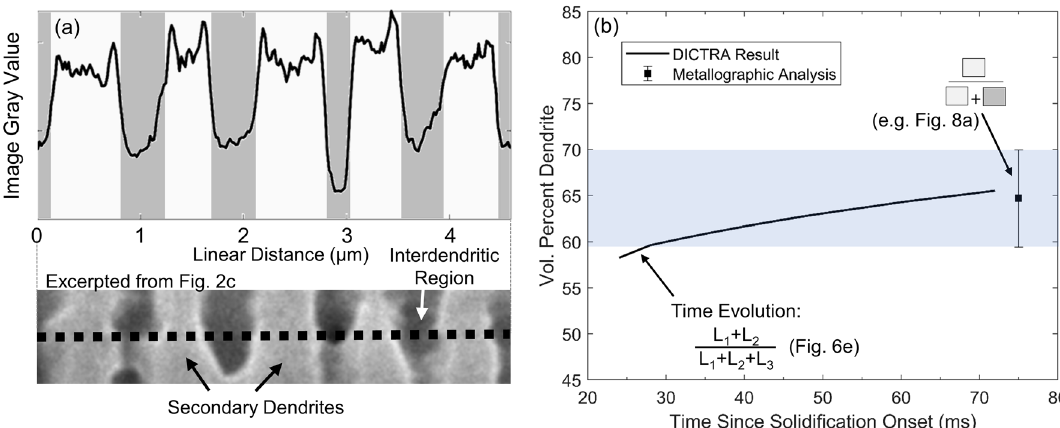
Figure 8. ( a ) Example gray-value profile and corresponding location on an SEM micrograph, illustrating the means of estimating dendrite fraction from postmortem metallography. ( b ) Plot comparing the dendrite fraction evolution during Stage III, calculated from DICTRA, with the dendrite fraction estimated from metallographic